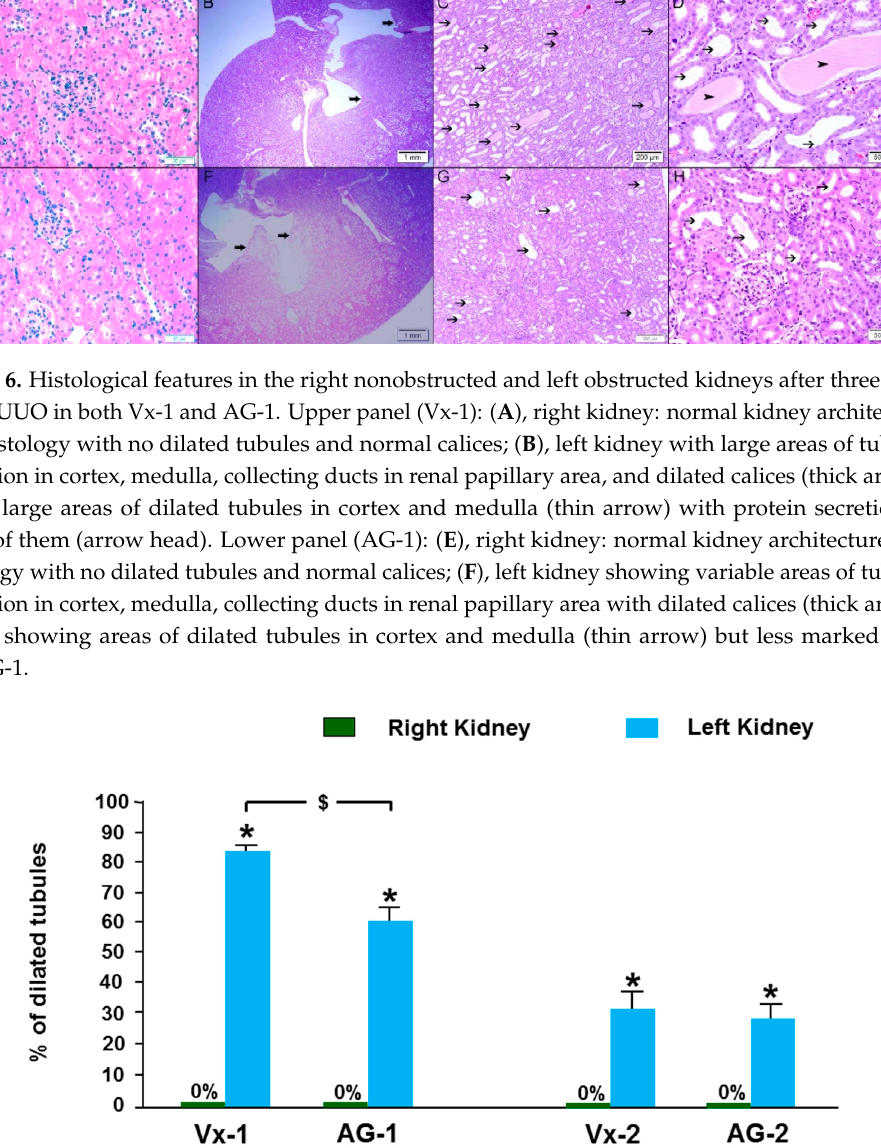
Figure 7. The degree of renal tubular dilatation in the right and left kidneys in all groups expressed as percentage. Values represent mean ± SEM. * indicates statistical significance between the right and left kidney within the same group.